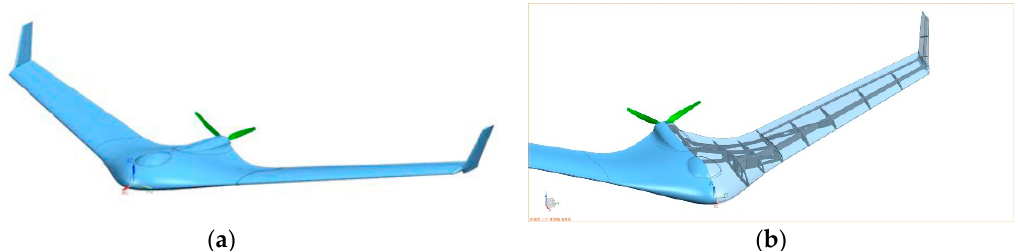
Figure 6. ( a ) External structure and ( b ) internal structure of flying wing UAV.